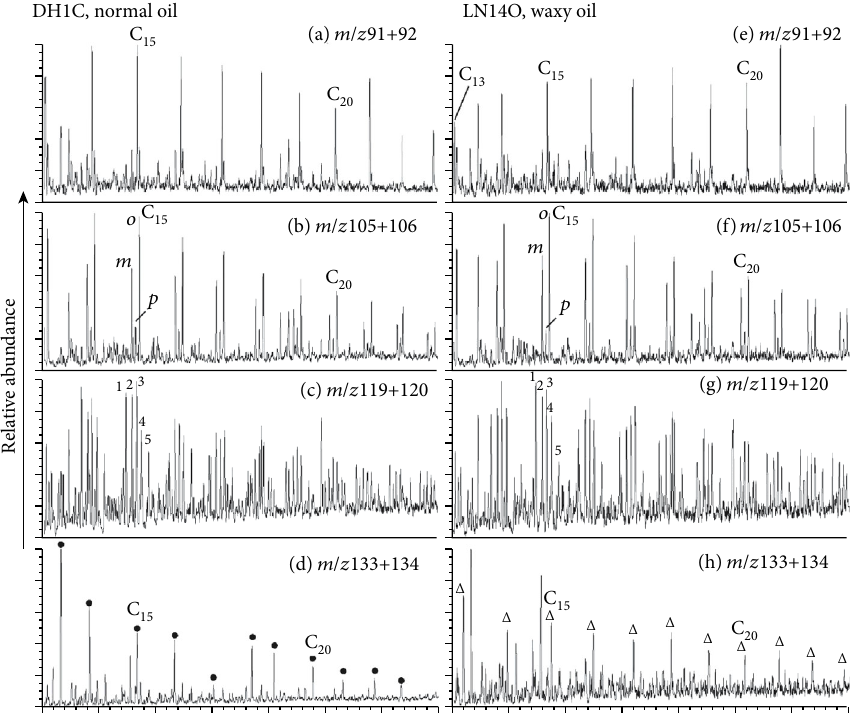
Figure 3: m/z 91+92, 105+106, 119+120, and 133+134 mass chromatograms (full scan mode) of the aromatic fractions from the oils (a – d) DH1C and (e – h) LN14O showing the distributions of n -alkylbenzene series. The labels ( m , p , and o ) in (b) and (f) denote the meta -, para -, and ortho isomers of methyl- n -alkylbenzene. Numbers 1 – 5 in (c) and (g) denote 3,5-, 2,5-, 2,4-, 3,4-, and 2,3-dimethyl isomers of dimethyl- n - alkylbenzene. The 2,6-dimethyl isomer elutes shortly after the 3,4-dimethyl isomer and exists in very low abundance (structure assignment was made according to the result of Ellis et al. [37]). Filled circles and un fi lled triangles in (d) and (h) indicate AIPs and AAs, methyl isomers were detected in much higher abundance rel- ative to the para- methyl isomer (Figures 3(b) and 3(f)). Among the six isomers of dimethyl- n -alkylbenzenes, the (Figure 3). For methyl- n -alkylbenzenes, the meta - and ortho-